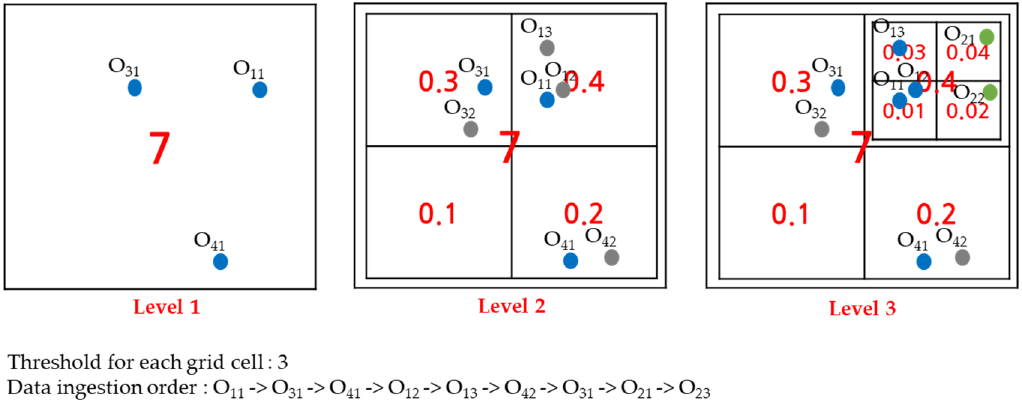
Figure 7. Example of dynamic grid indexing.